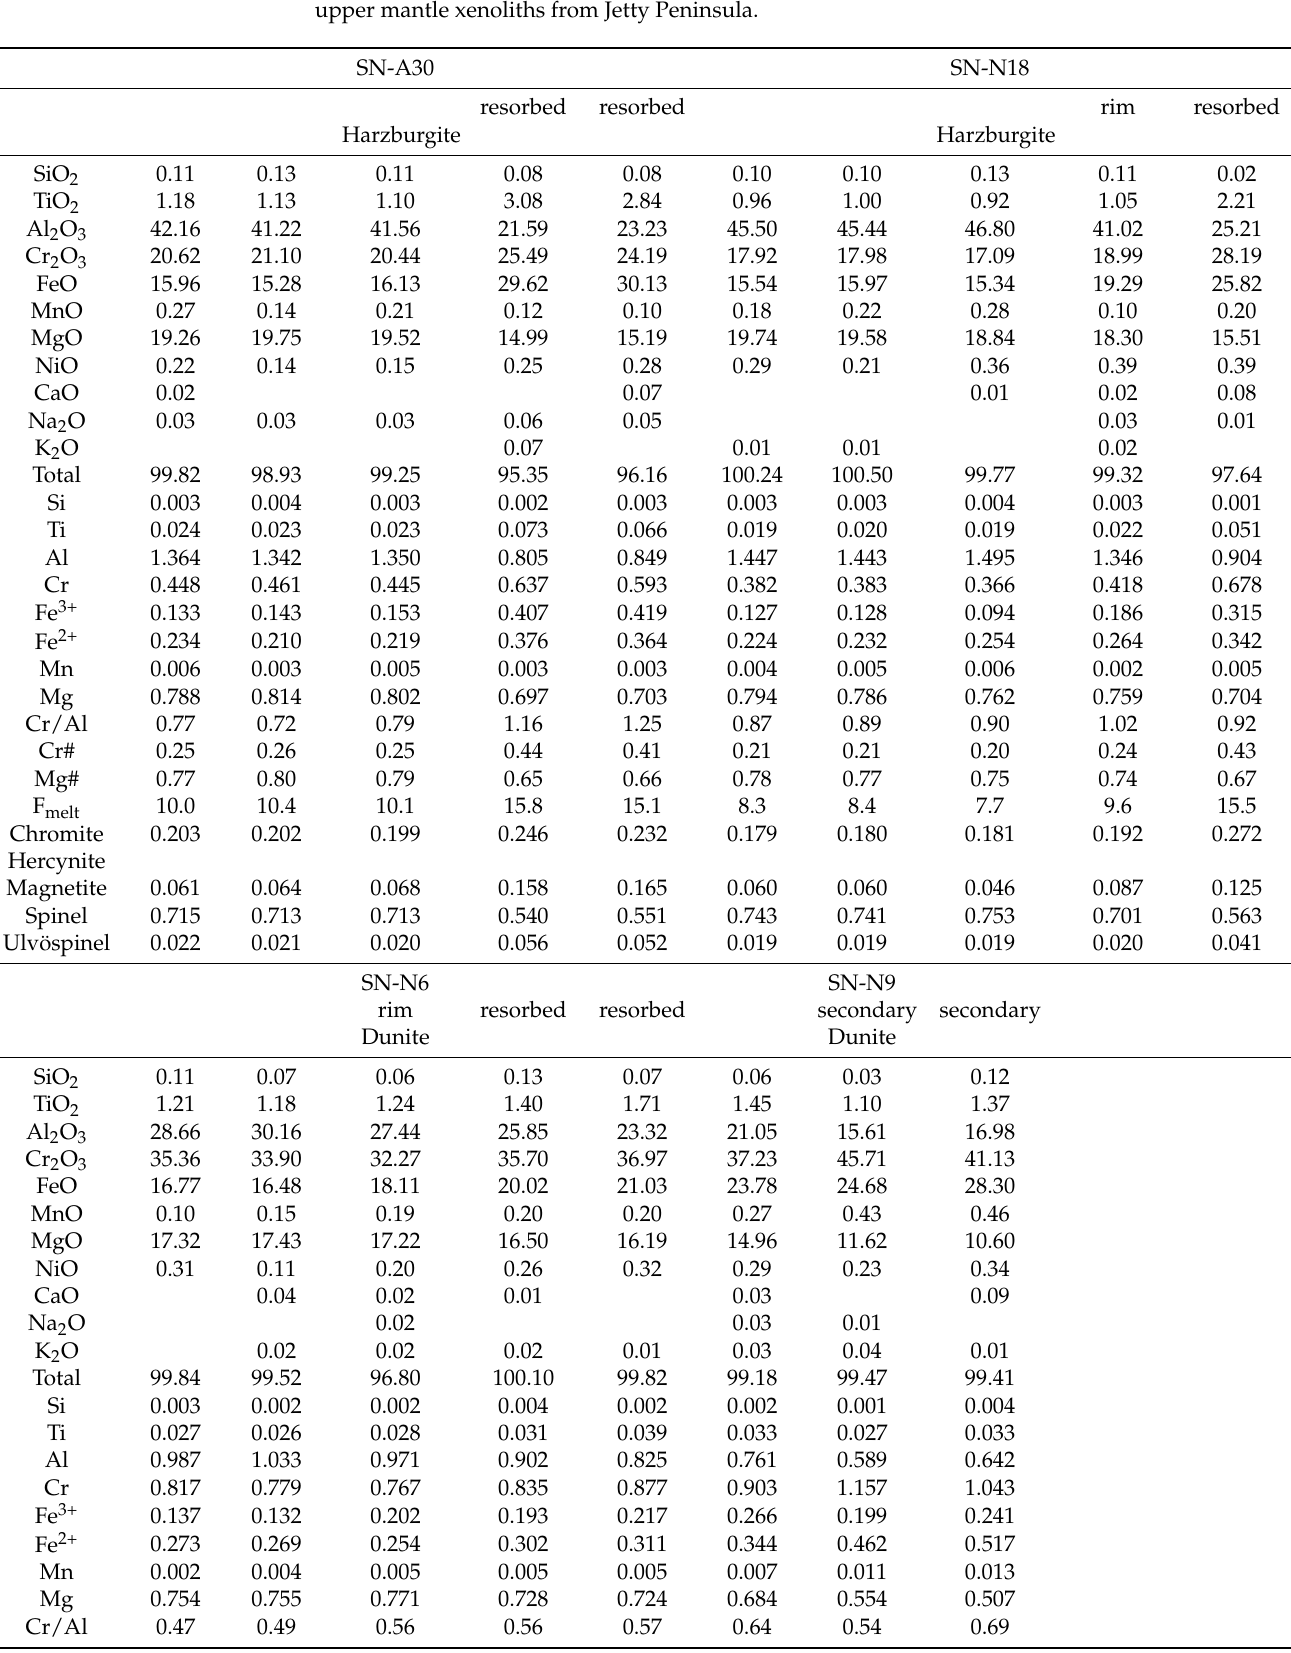
Table 2. Representative major oxide (wt%) and mineral compositions of spinel in non-lherzolite upper mantle xenoliths from Jetty